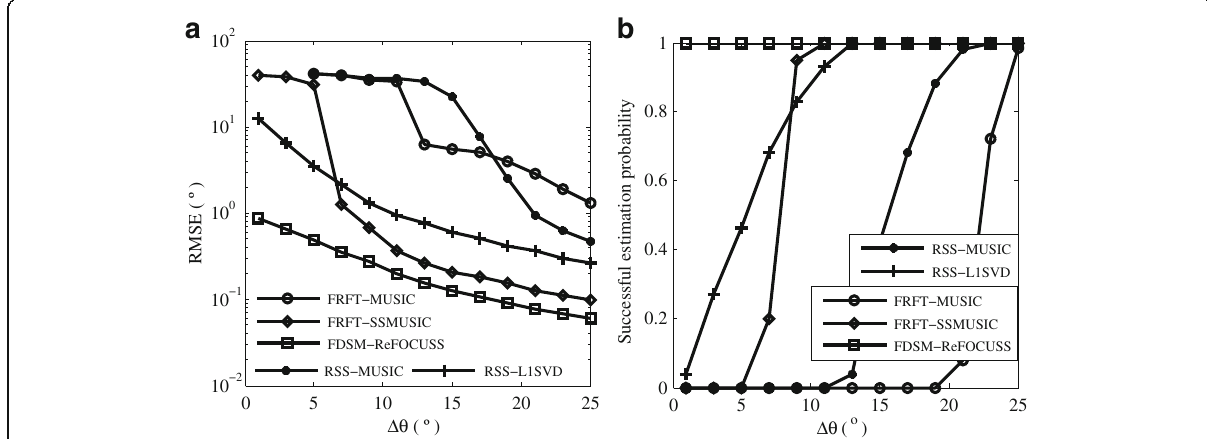
Fig. 6 Estimation performances versus angle difference for coherent wideband LFM signals. a Estimation error. b Successful estimation